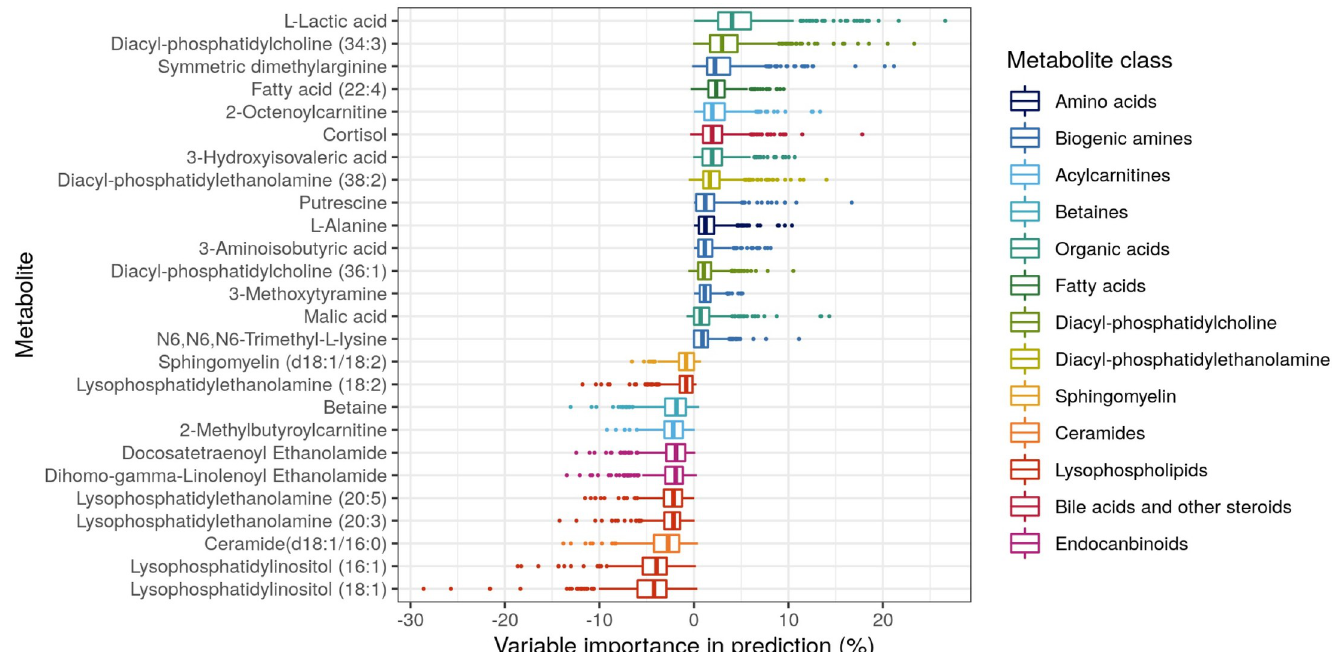
Fig 4. Variable importance of metabolites for the prediction of an atypical bacterial infection versus S . pneumoniae and viral infections. Only metabolites with an absolute mean percentage of influence > 1% are visualized.